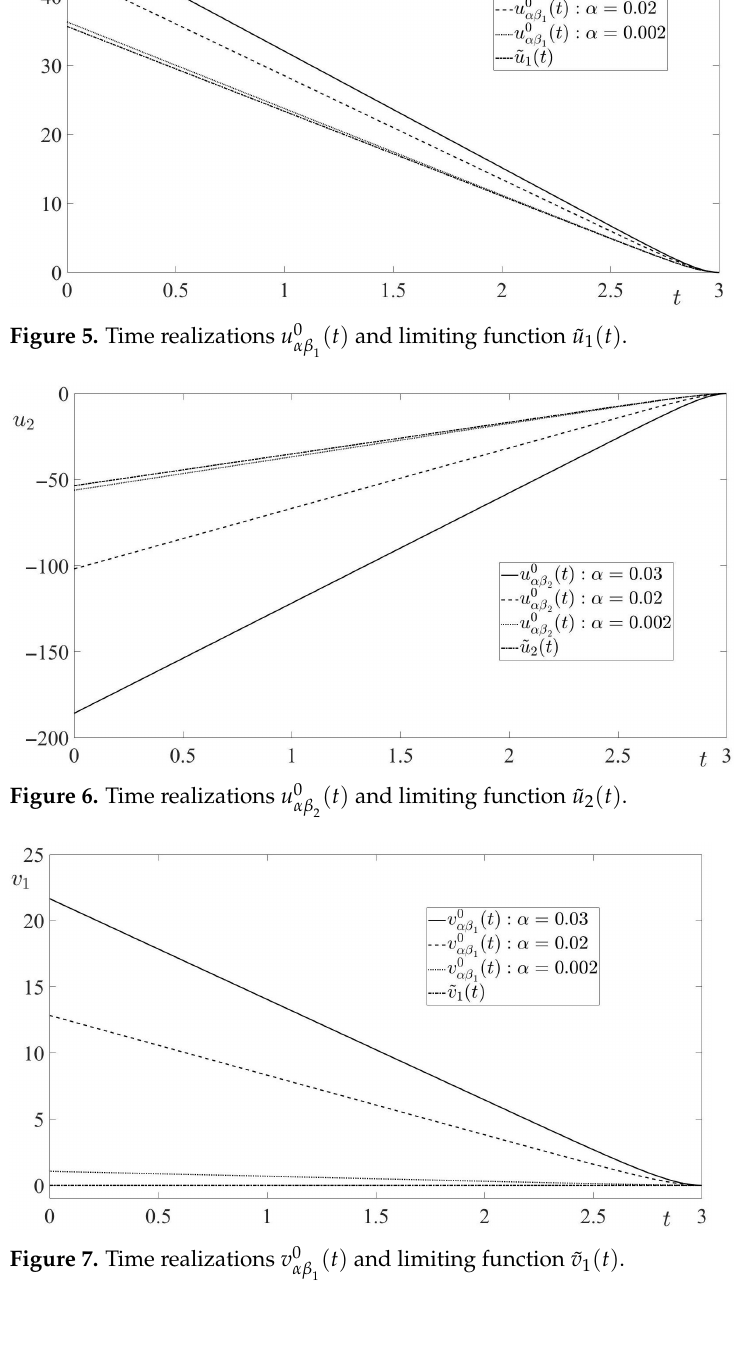
Figure 7. Time realizations v 0